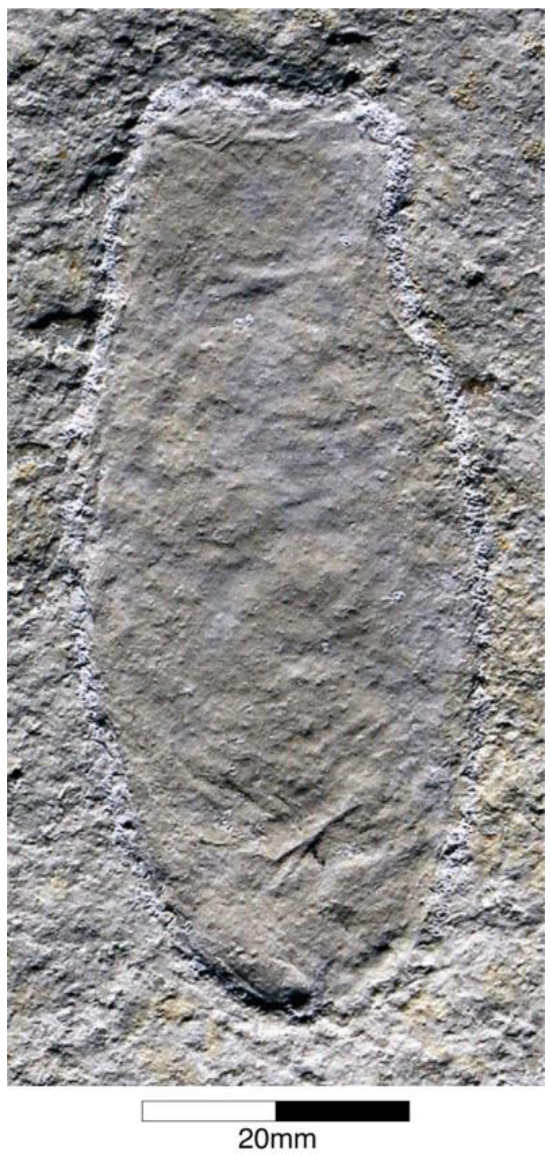
Figure 25. Scyliorhinid type egg capsule. † Scyliorhinotheca Kiel et al., 2013 [251] (collection Resch, JMS 456) from the Solnhofen